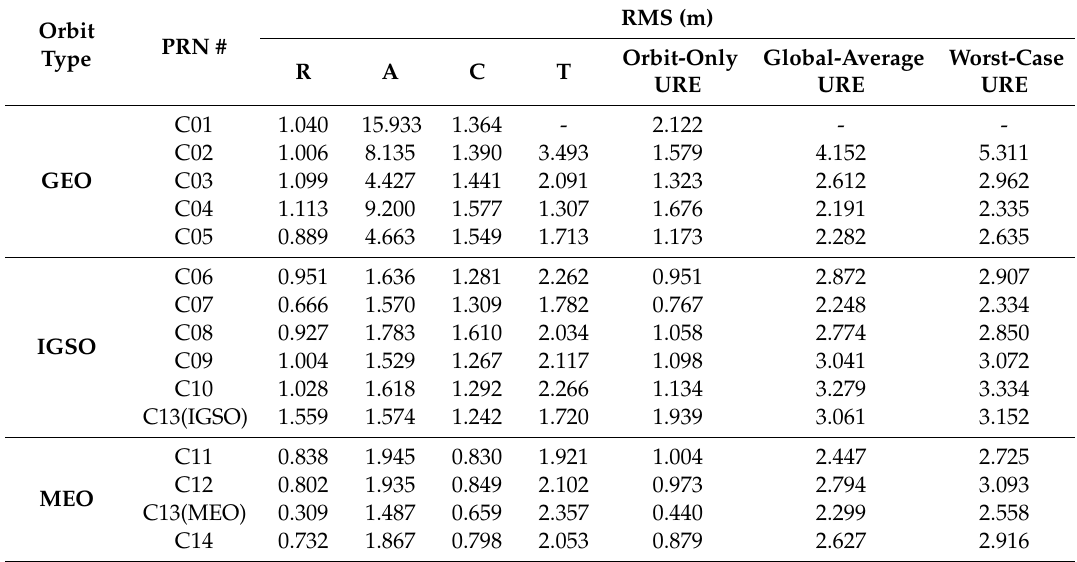
Figure 8. Six-year BDS broadcast navigation message orbit/clock errors and signal-in-space (SIS) UREs RMS. Table 4. Statistics of six-year BDS broadcast navigation message orbit/clock errors and SIS UREs RMS.